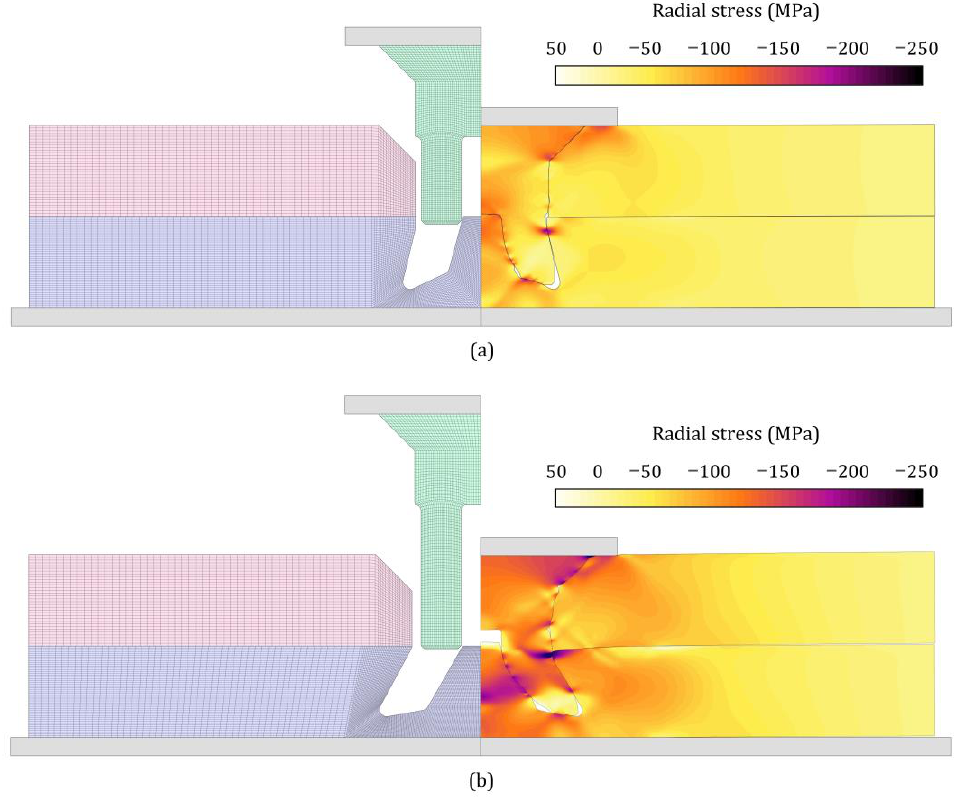
Figure 6. Finite element simulation of injection lap riveting with countersunk head rivets showing the mesh at the beginning (left) and the distribution of radial contact pressure (MPa) at the end of the stroke (right) for two-unit cells corresponding to ( a ) 𝛼 = 15°, 𝑑 𝑝 = 4 mm and ( b ) 𝛼 = 30°, 𝑑 𝑝 = 4 mm.